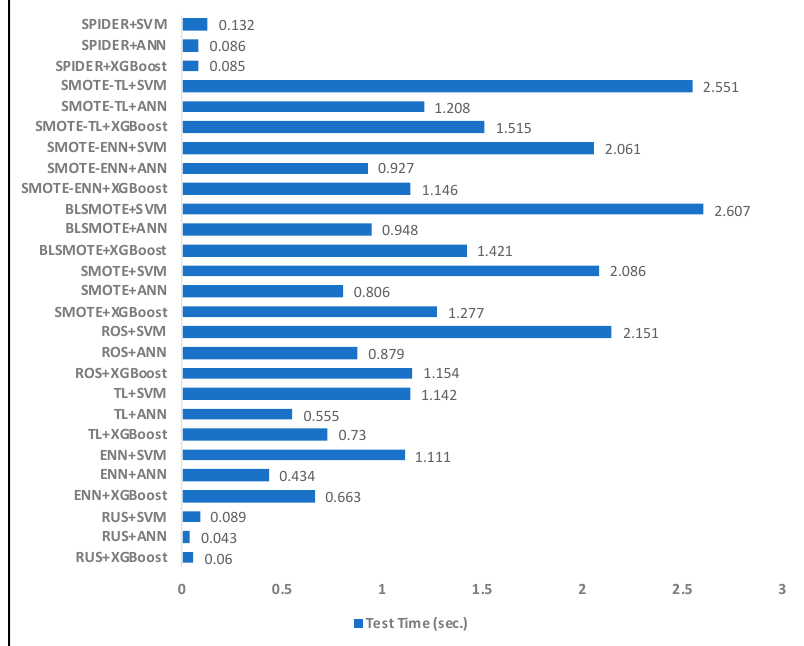
Figure 10. Training time (s) for all the fusion models.